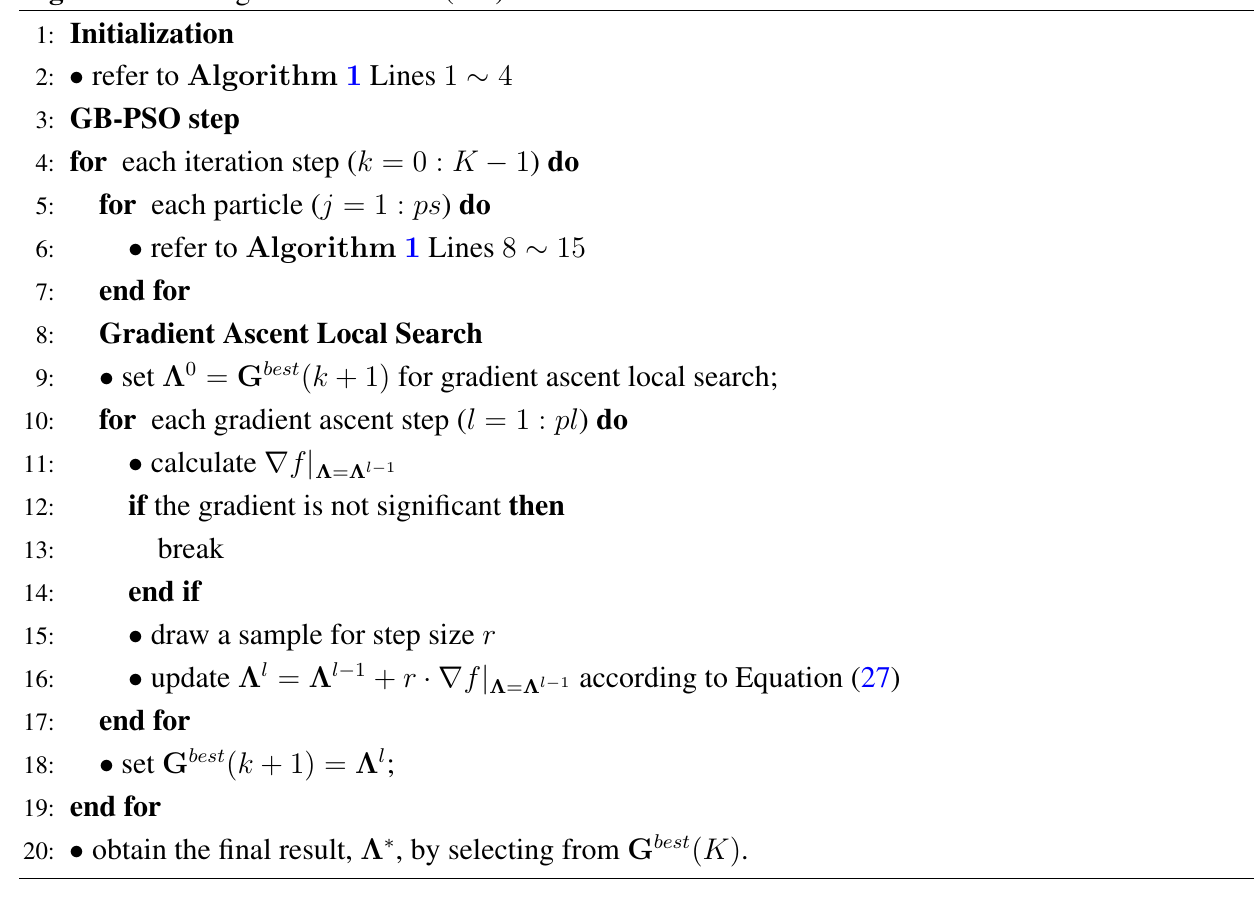
Algorithm 2 The gradient-boosted (GB)-PSO